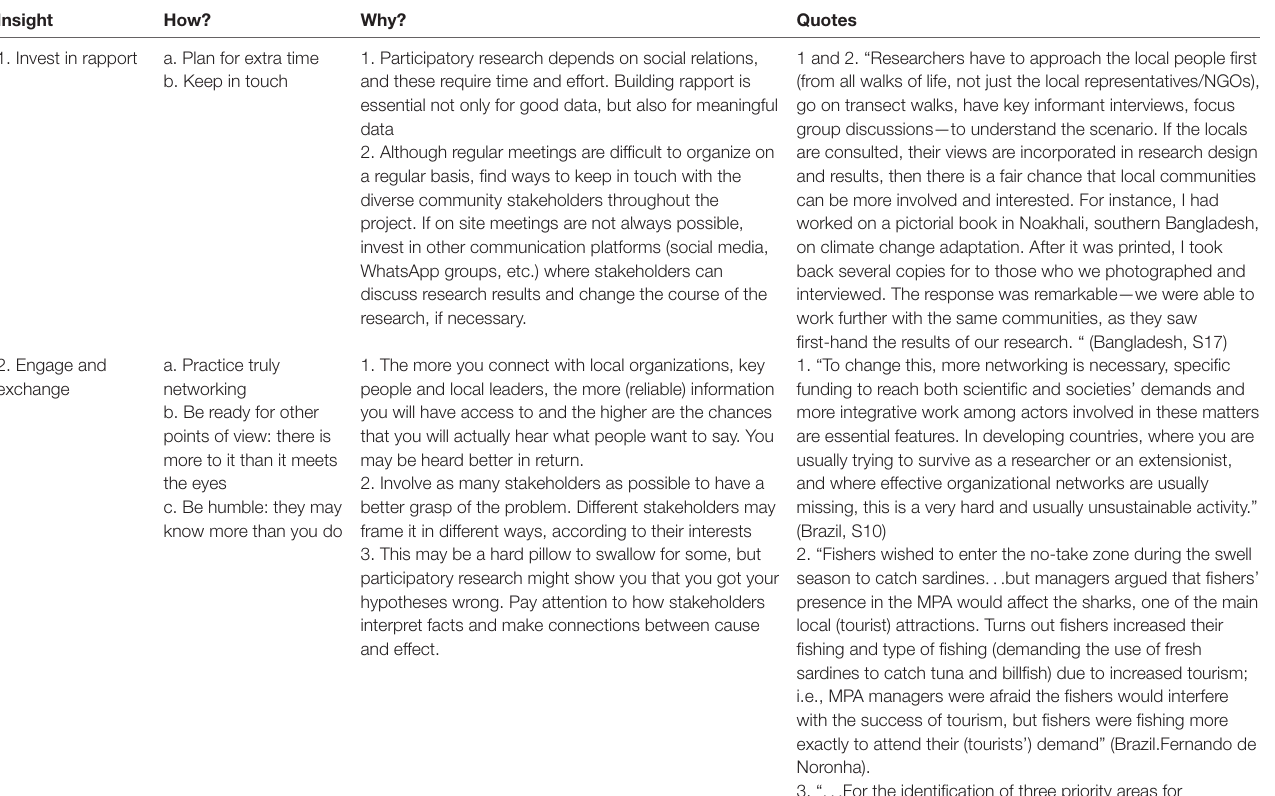
TABLE 1 | Summary of insights by transdisciplinary researchers working with marine socio-ecological systems (2019 survey).